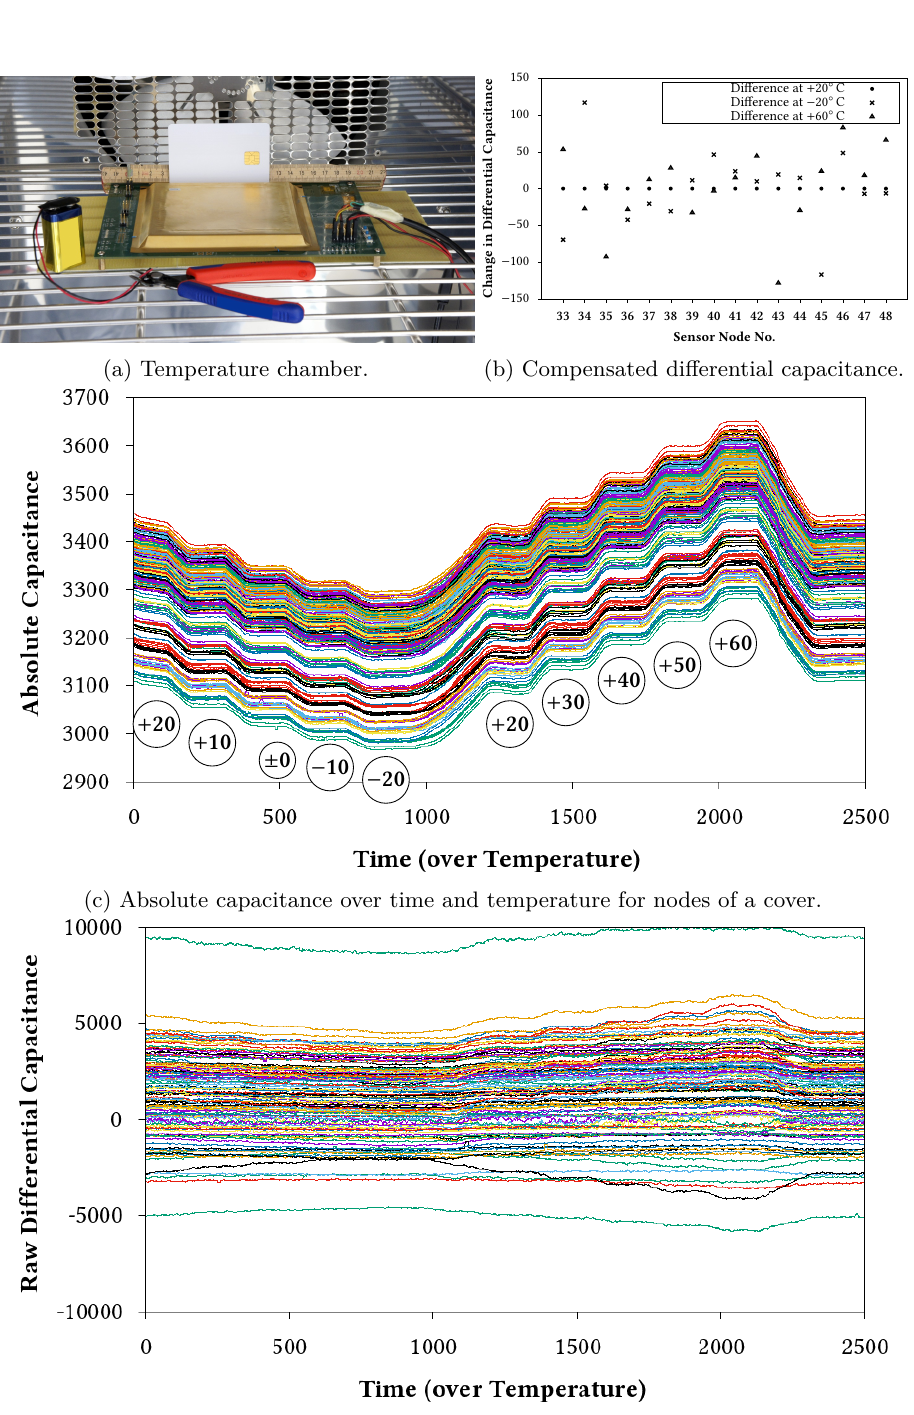
Figure 26: Environmental tests and results. Plots in Figure 26c and Figure 26d have the identical time axis, i.e., they both cover the temperature range from +20 ◦ C to − 20 ◦ C, then to +60 ◦ C, and back to room temperature during the same test